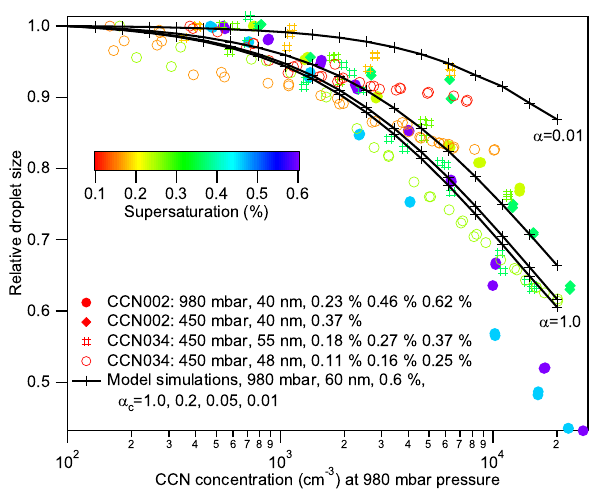
Fig. 8. Relative droplet size (normalized by that of the lowest CCN concentration) as a function of CCN concentration from four ex- periments and constant velocity model simulations. Experimental and simulation details (instrument serial number, pressure, geomet- ric mean dry diameter for experiments and dry particle size for sim- ulations, supersaturations, and water uptake coefficient for simula- tions) are given in the figure. The experimental results are colored by supersaturation. Both the experiments and simulations represent cases with relatively large vapor depletion effect. The 980mbar ex- perimental data is from Lathem and Nenes